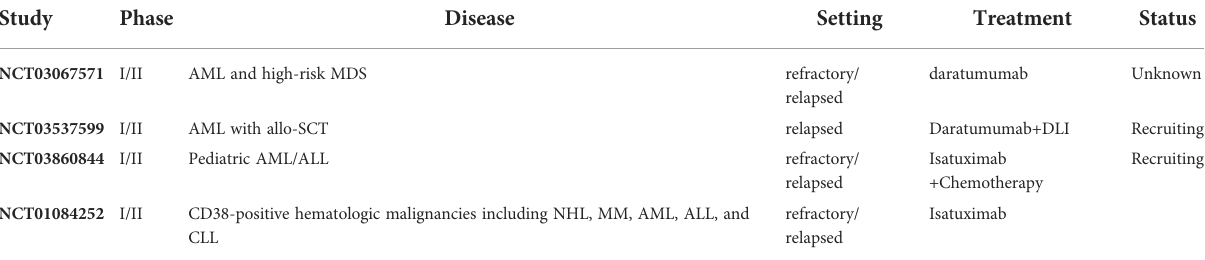
TABLE 3 Clinical trials of CD38 mAbs in